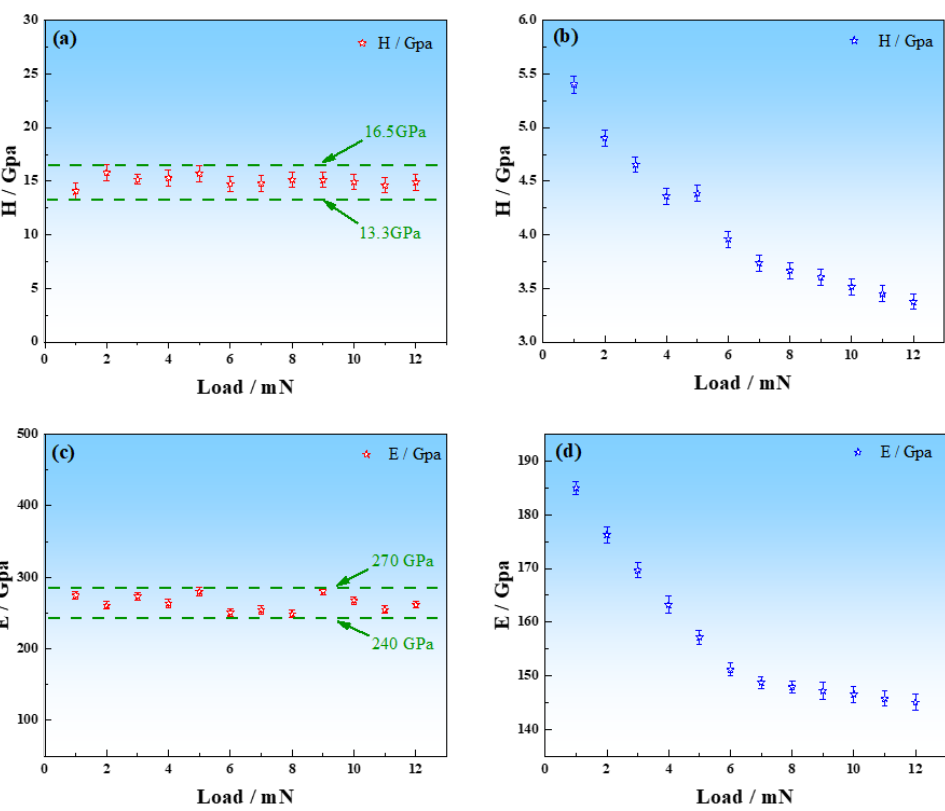
Figure 8. Relationship between nano-hardness H and nano-indentation load of the ( a ) σ -phase and ( b ) austenitic phase. Relationship between the Young’s modulus E and nano-indentation load of the ( c ) σ -phase and ( d ) austenitic phase.